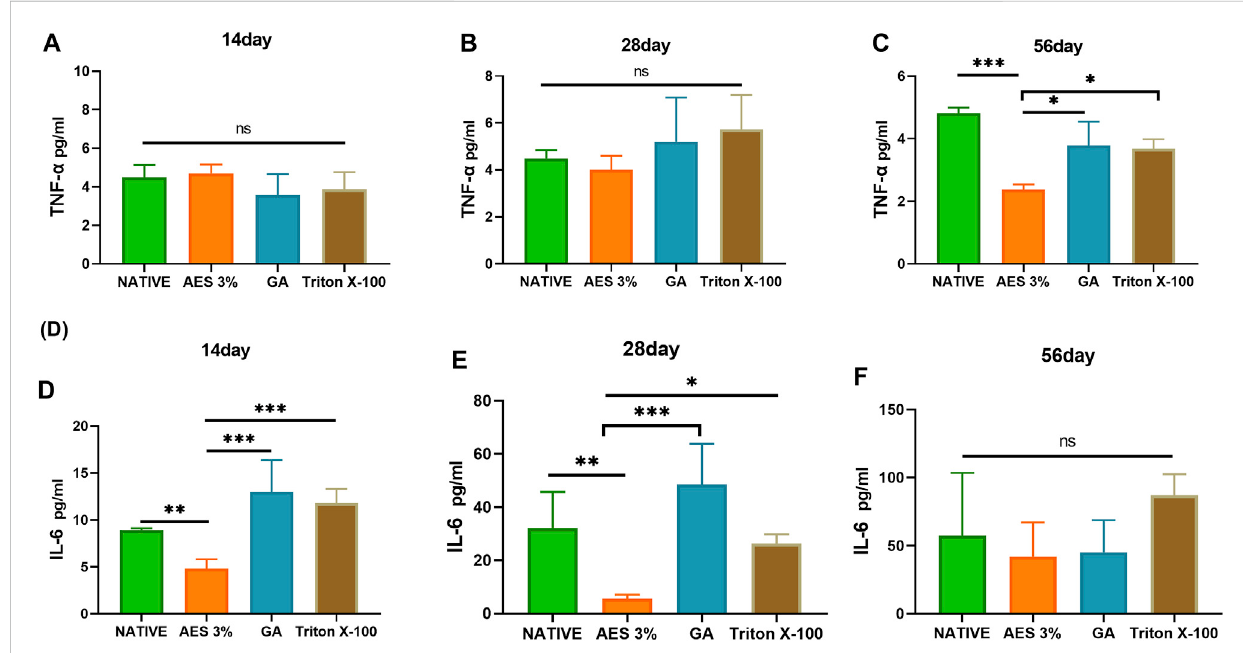
FIGURE 9 Expression of pro-in fl ammatory factors in serum in 14 days, 28 days, 56 days. (A – C) TNF- α (D – F) , IL-6 (n = 3; * p < 0.05; ** p < 0.01; *** p < 0.001; ns represents no signi fi cant